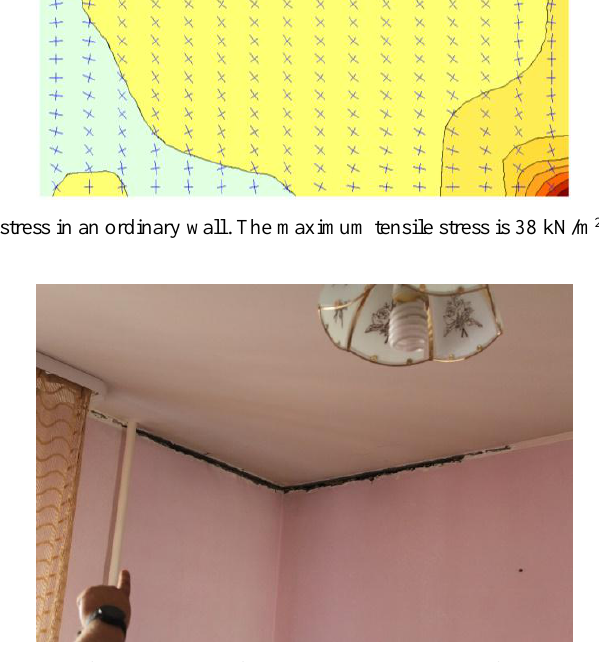
Fig. 4. Examples of cracks that formed between floor slabs and vertical wall filling.